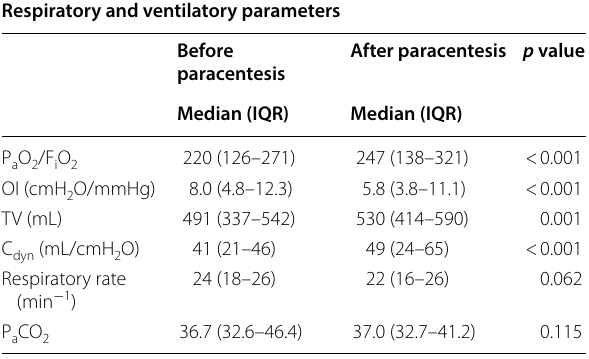
Table 5 Respiratory and ventilatory parameters